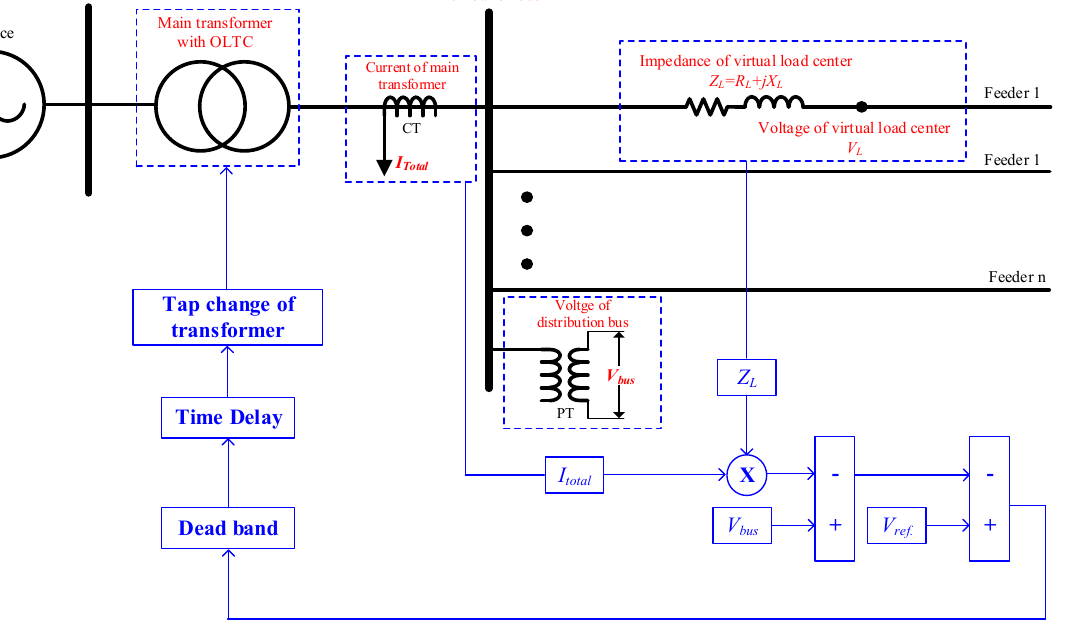
Figure 1. Mechanism of the LDC method.